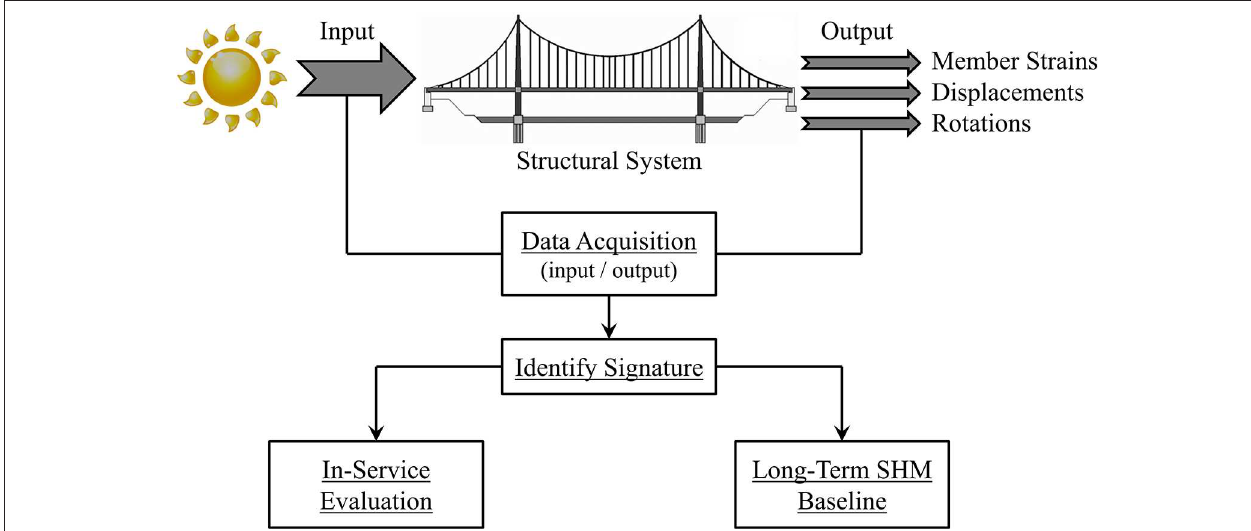
FIGURE 1 | Temperature-driven bridge evaluation and monitoring approach.